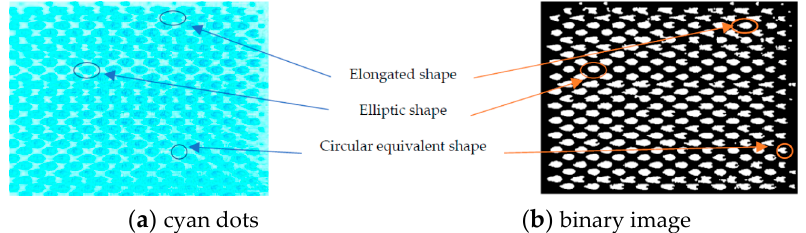
Figure 13. Another example of results for a cyan print with a cell angle of 60°. % of dots belonging to category ID1 (34%), ID2 (0%), ID3 (0%), ID4 (0%), ID5 (55%), ID6 (11%, most of them are at the border of the figure). There is no missing dot. In total, 62% of dots have an elliptic shape, while 25% of dots have an elongated shape (less than 1% has a circular shape).